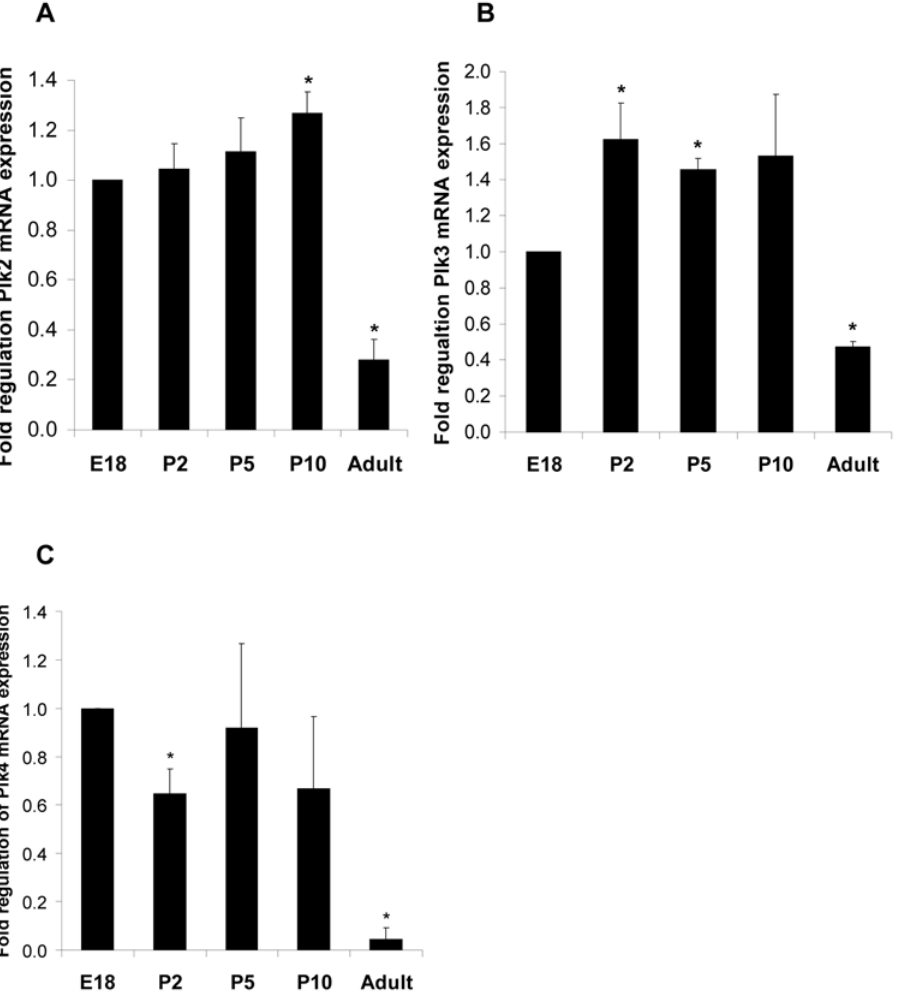
Figure 2. Regulation of Plk2, Plk3 and Plk4 mRNA expression during cardiac myocyte development. Ventricular cardiac myocytes were isolated from hearts at various stages of development (embryonic day 18 [E18], 2, 5 and 10 days postnatal [P2, P5 and P10] and adult [250 g males]) and assessed for Plk2, Plk3 and Plk4 mRNA (black bars, A, B and C, respectively). Samples were normalised to GAPDH. Each bar chart represents data from at least 3 separate experiments, * p , 0.05.